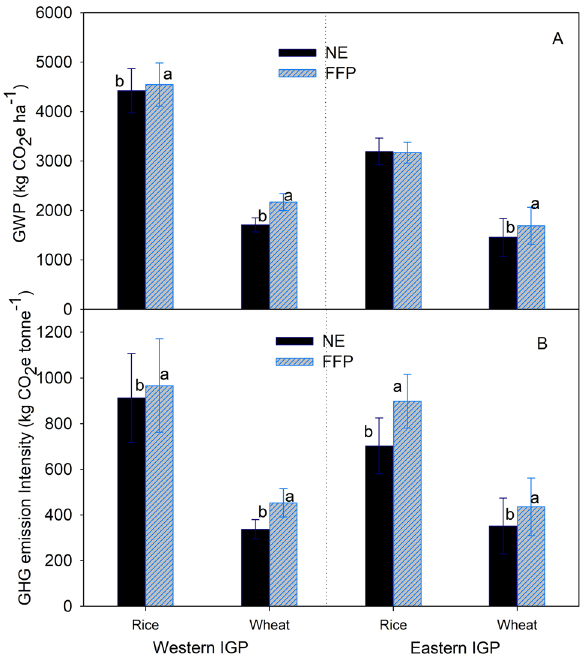
Figure 3. Total global warming potential ( A ) and emission intensity ( B ) from rice and wheat production under NE and FFP in the study areas. Values are average of all the comparison trials over the study period. Within each pair, bars bearing different lower case letters are significantly different from each other based on a paired t-test (p = 0.05). Error bar shows the standard deviation. IGP = Indo-Gangetic